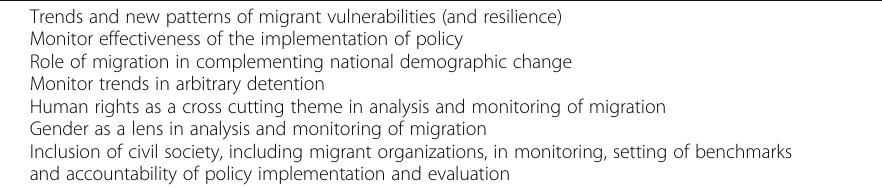
Table 1 Proposals for data and research: Thematic Session I Human rights of all migrants, social inclusion, cohesion and all forms of discrimination, including racism, xenophobia and intolerance